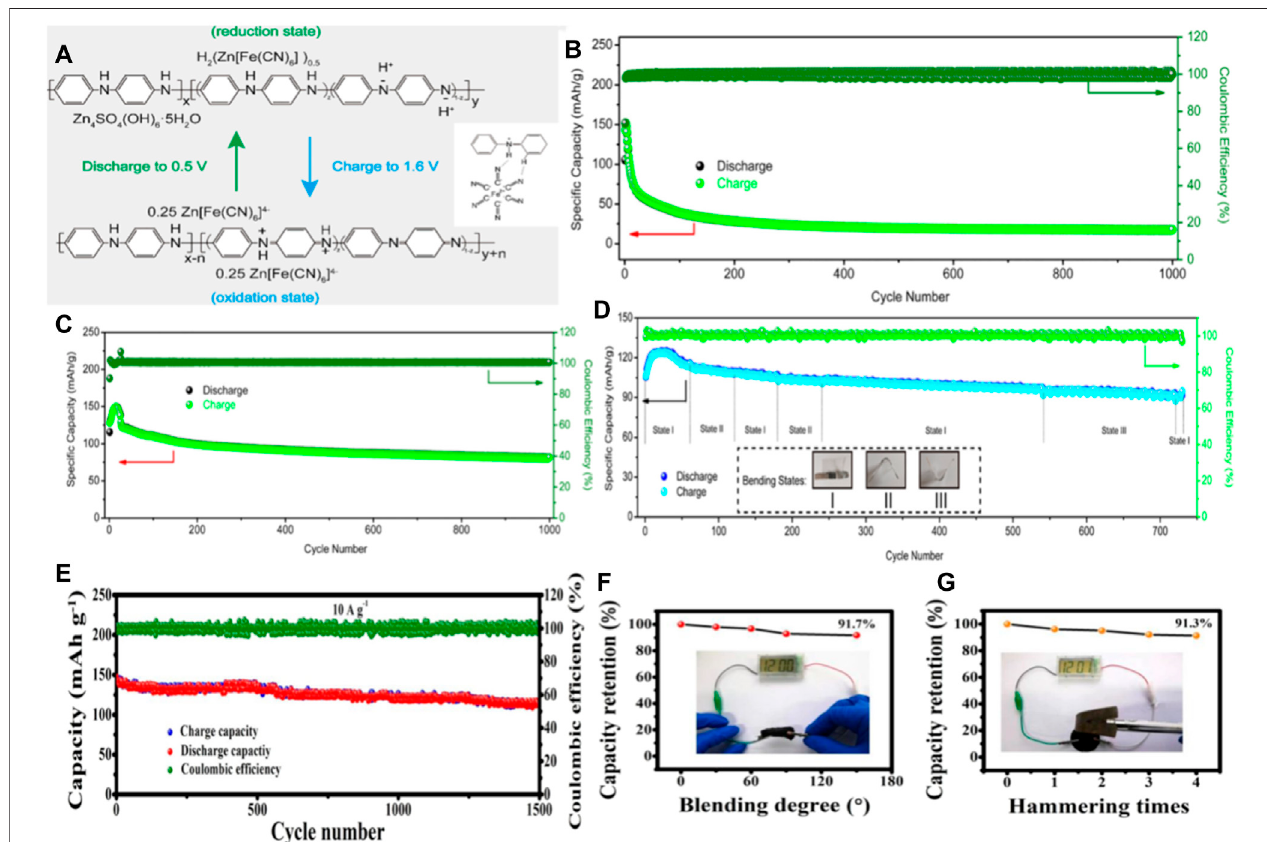
FIGURE 4 | (A) REDOX mechanism of CC-PANI-FeCN. Illustration[Fe(CN) 6 ] 4 − Schematic diagram of interaction with PANI. Cyclic properties of CC-PANI (B) and CC-PANI-FeCN (C) atcurrentdensity5A/g. (D) Theopticalimagesofquasi-solid-state fl exiblebatteriesindifferentbendingstates.Copyright2020ChemicalEngineering Journal. (E) Cyclingperformanceoft-CNT-PA-PEcathodeinZIBsatcurrentdensityof10A/g.CapacityretentionofsolidZIBsunderdifferentdestructivetests,including (F) bending test and (G) hammer testCopyright 2019 ACS Appl Mater